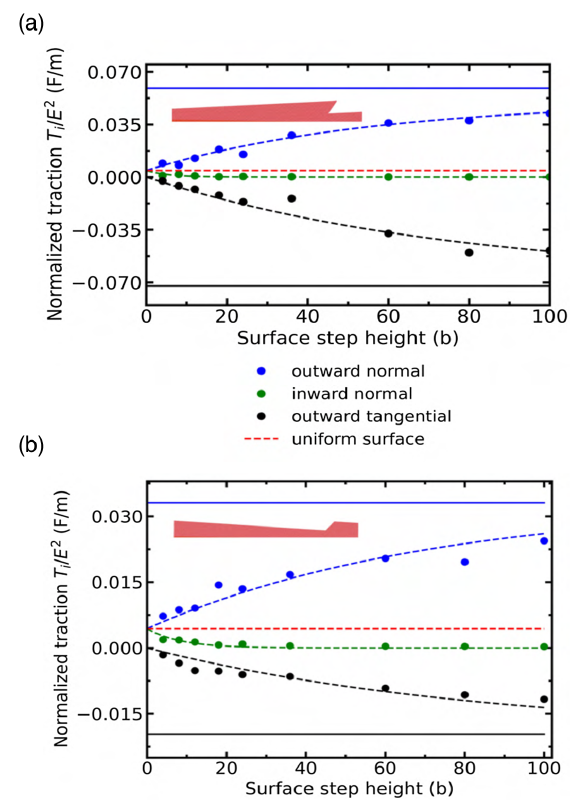
FIG. 2. Surface traction components under an electric field of 10 GV = m acting normal to the surface for a structure with slip step height of 18 b. The shaded region highlights the sharp change in traction magnitude due to the presence of slip step (magnified atomistic configuration inset).